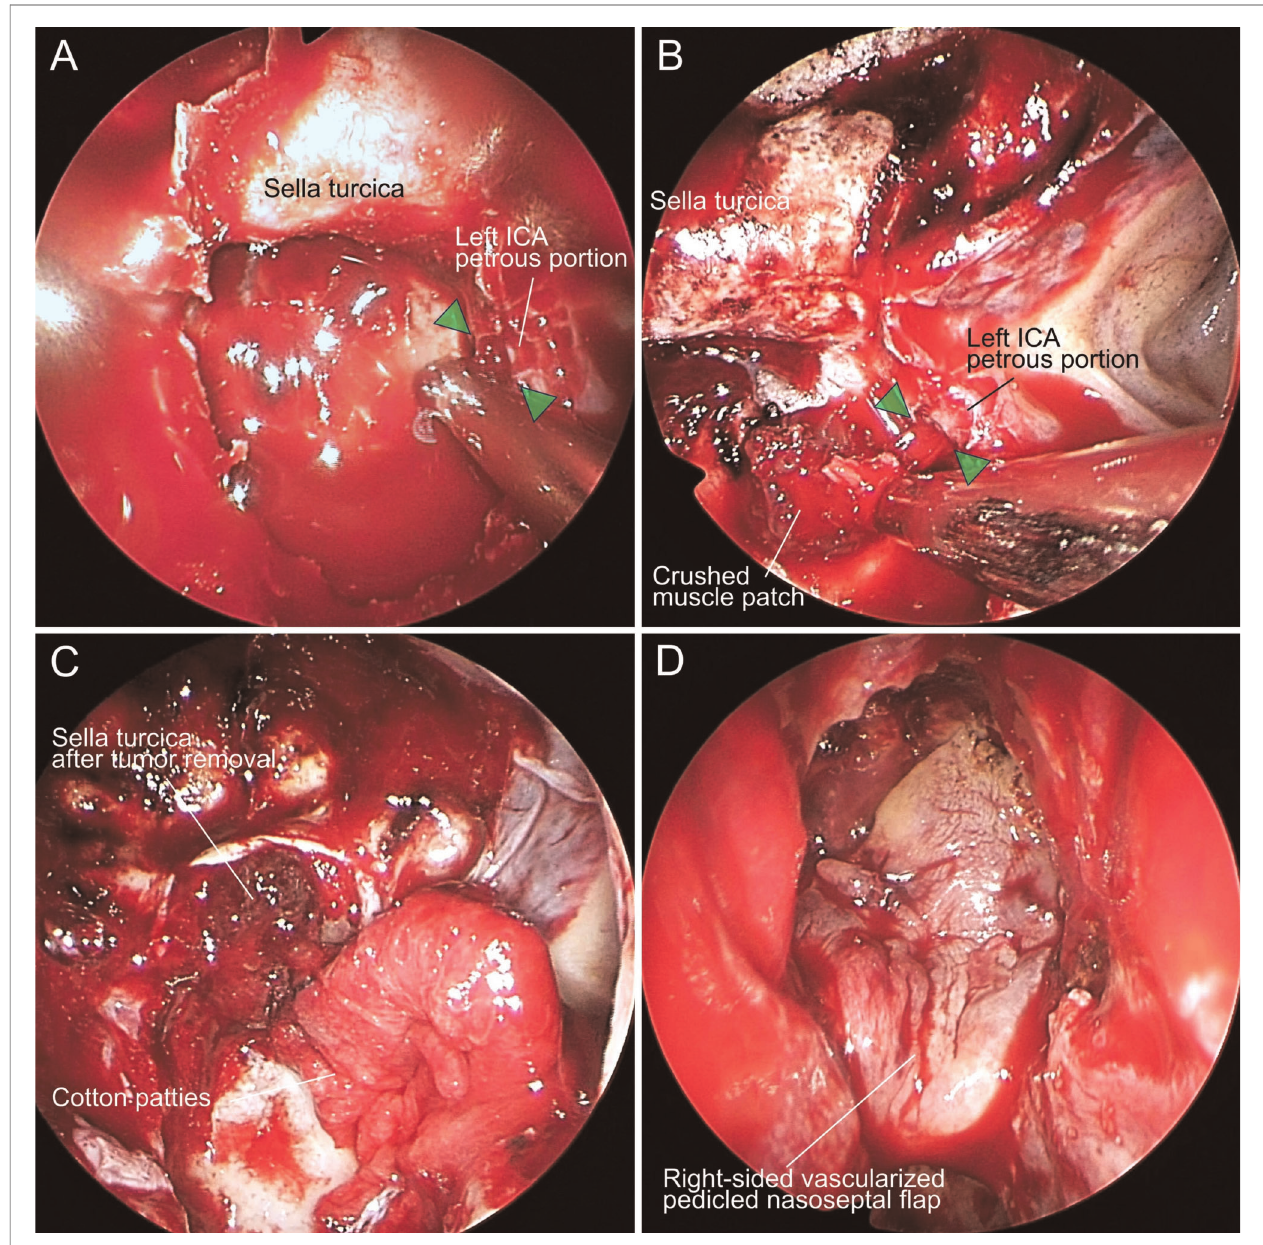
FIGURE 2 | Intraoperative photographs of the endoscopic transsphenoidal surgery that caused internal carotid artery (ICA) injury. ( A ) Petrous portion of the left ICA was injured (green arrowheads). ( B ) Crushed muscle patch was unsuccessfully applied to the injured site (green arrowheads) of the left ICA. ( C ) Injured site of the left ICA was covered with cotton patties. ( D ) Surgical fi eld was closed using the right-sided vascularized pedicled nasoseptal fl